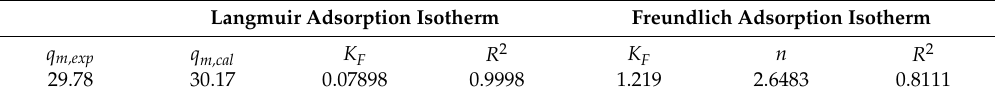
Table 3. Compare the adsorption process parameters of different absorbents to remove tetracycline from water.